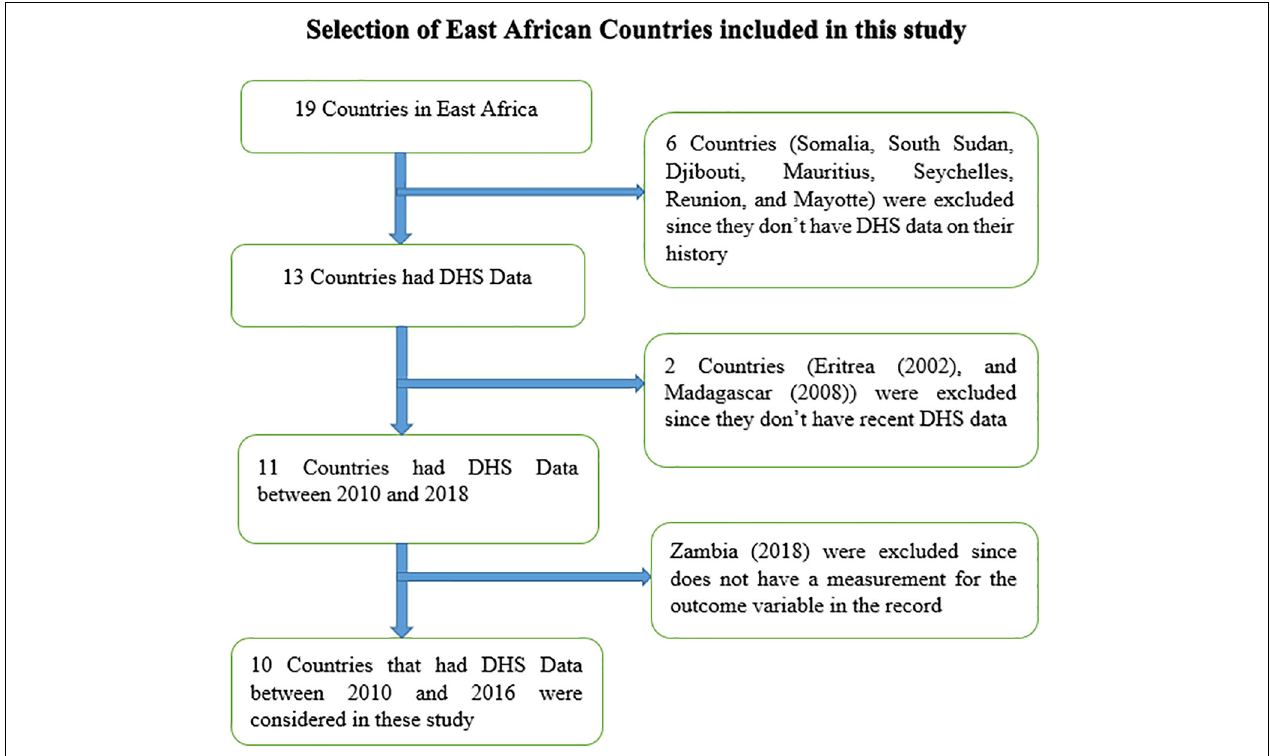
FIGURE 1 | Schematic diagram for the selection of East African countries included in the analysis of DHS data from 2010 to 2016.